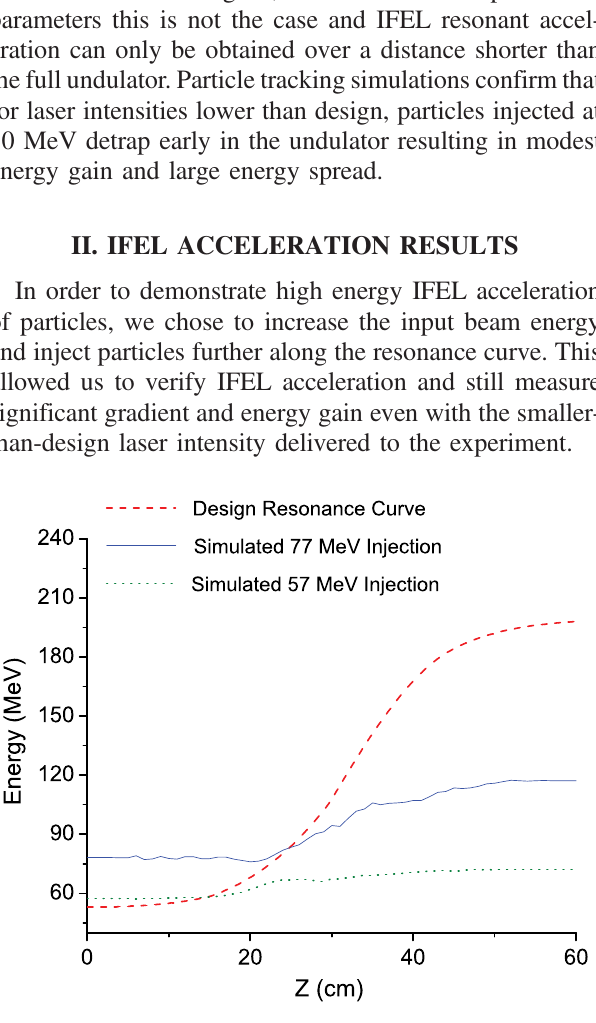
FIG. 3. Evolution along the undulator of the design resonant energy (red-dashed) and of the simulated maximum energy for 57 MeV (green-dotted) and 77 MeV (blue-solid) injection as used in the